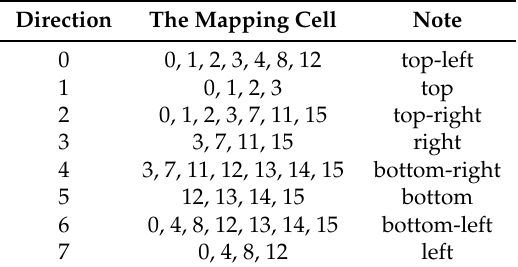
Table 2. Lookup Table. By estimating the motion direction of the image, the map is constructed using the corresponding cells.